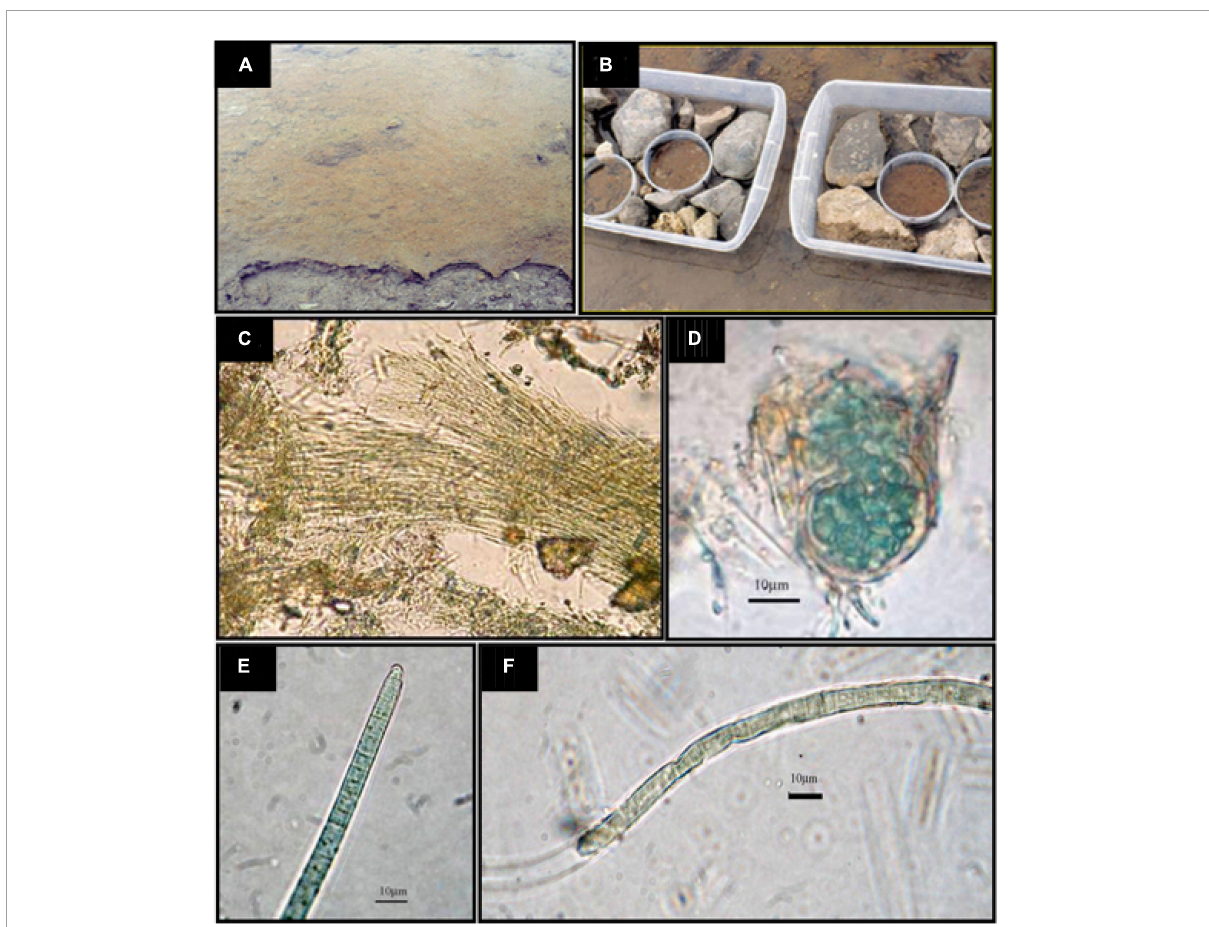
FIGURE1 (A) An image of the site where samples were picked up. (B) The fragments of the mat for experimental nutrient additions were disposed of into PVC containers with a surface of 70 cm 2 and then submerged in stream water supplemented with nutrients (except the controls) per triplicate, according to the experimental design. Samples were prepared, taking care that fragments were perfectly fitted in with the container walls. (C) Leptolyngbya sp.; (D) Chroococcidiopsis sp.; (E) Phormidium autumnale ; (F) Oscillatoria